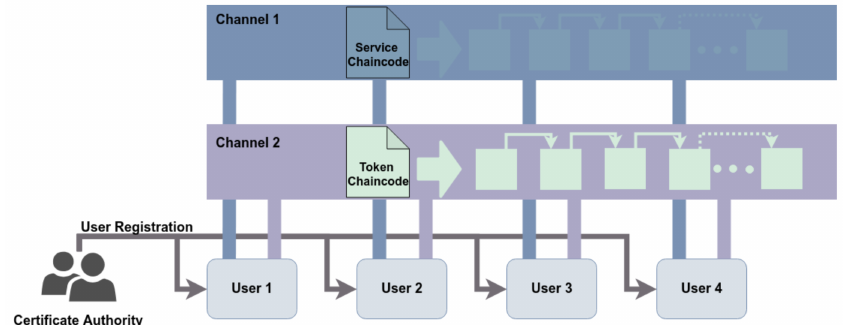
Figure 2. The underlying architecture of the proposed TimeBank system is founded based on Hyperledger Fabric’s multi-channel